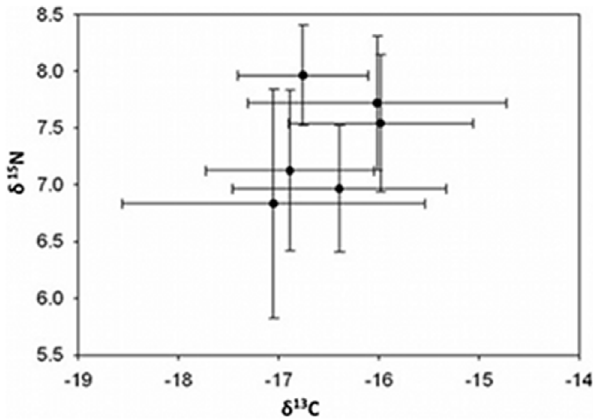
Figure 3. d 13 C and d 15 N stable isotopes values ( 6 SD) for YOY killifish collected from natural pool habitats. Killifish collected from individual pools did not differ in either carbon or nitrogen isotopic signatures, suggesting that fish collected from different pools had similar diets and dietary composition did not affect MeHg bioaccumu- lation.